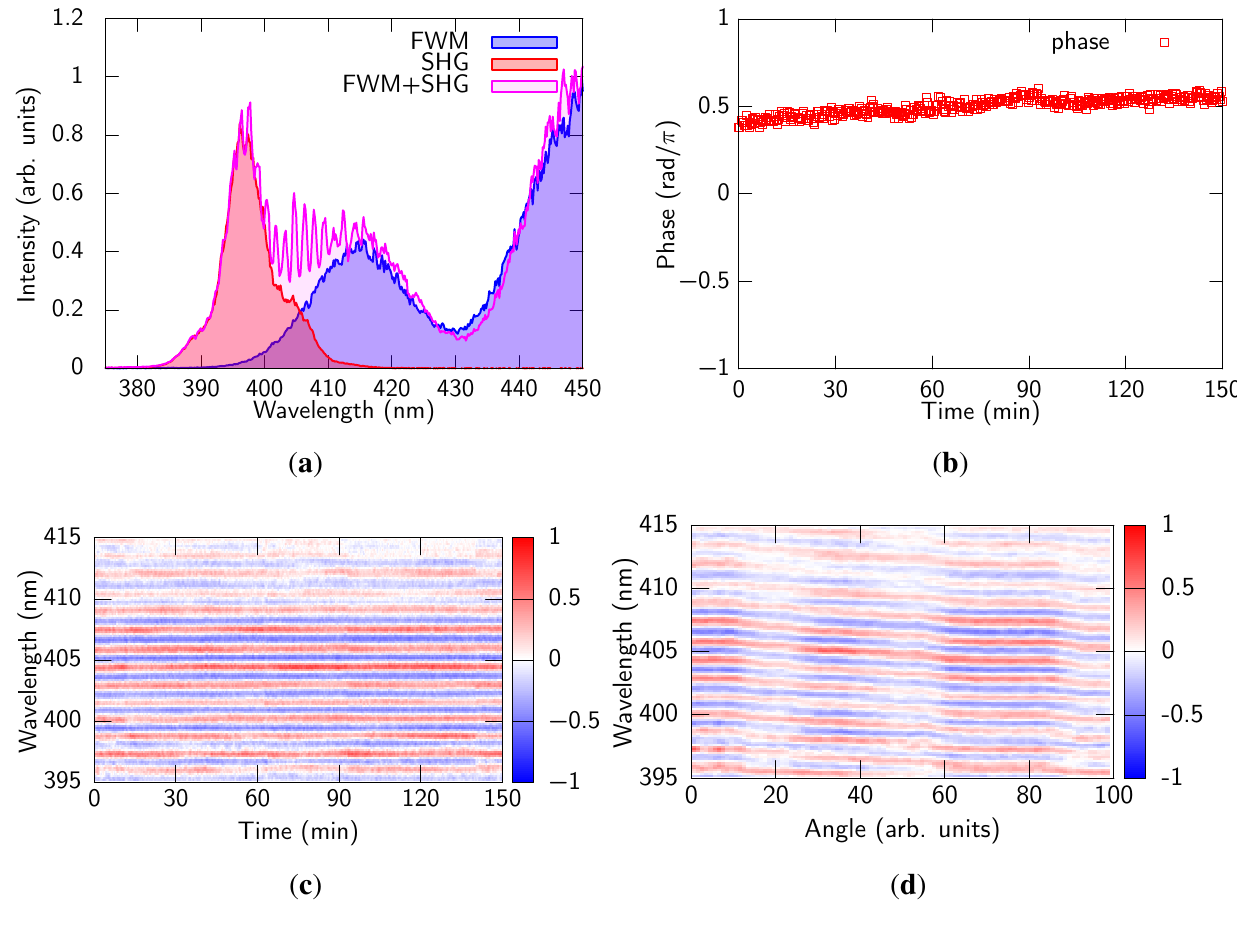
( a ) Interference signal between the SH of the reference pulse and the FWM signal; ( b ) Time evolution of the phase of the interference fringe; ( c ) Time evolution of the fringe pattern; Each fringe pattern was measured by single shot every 22 s; ( d ) Fringe pattern change by tilting the delay plate in Figure